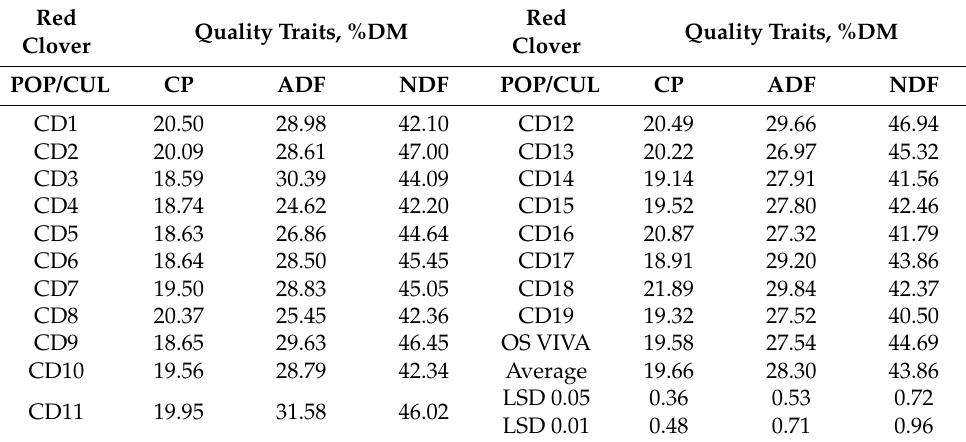
Red Quality Traits, %DM Clover